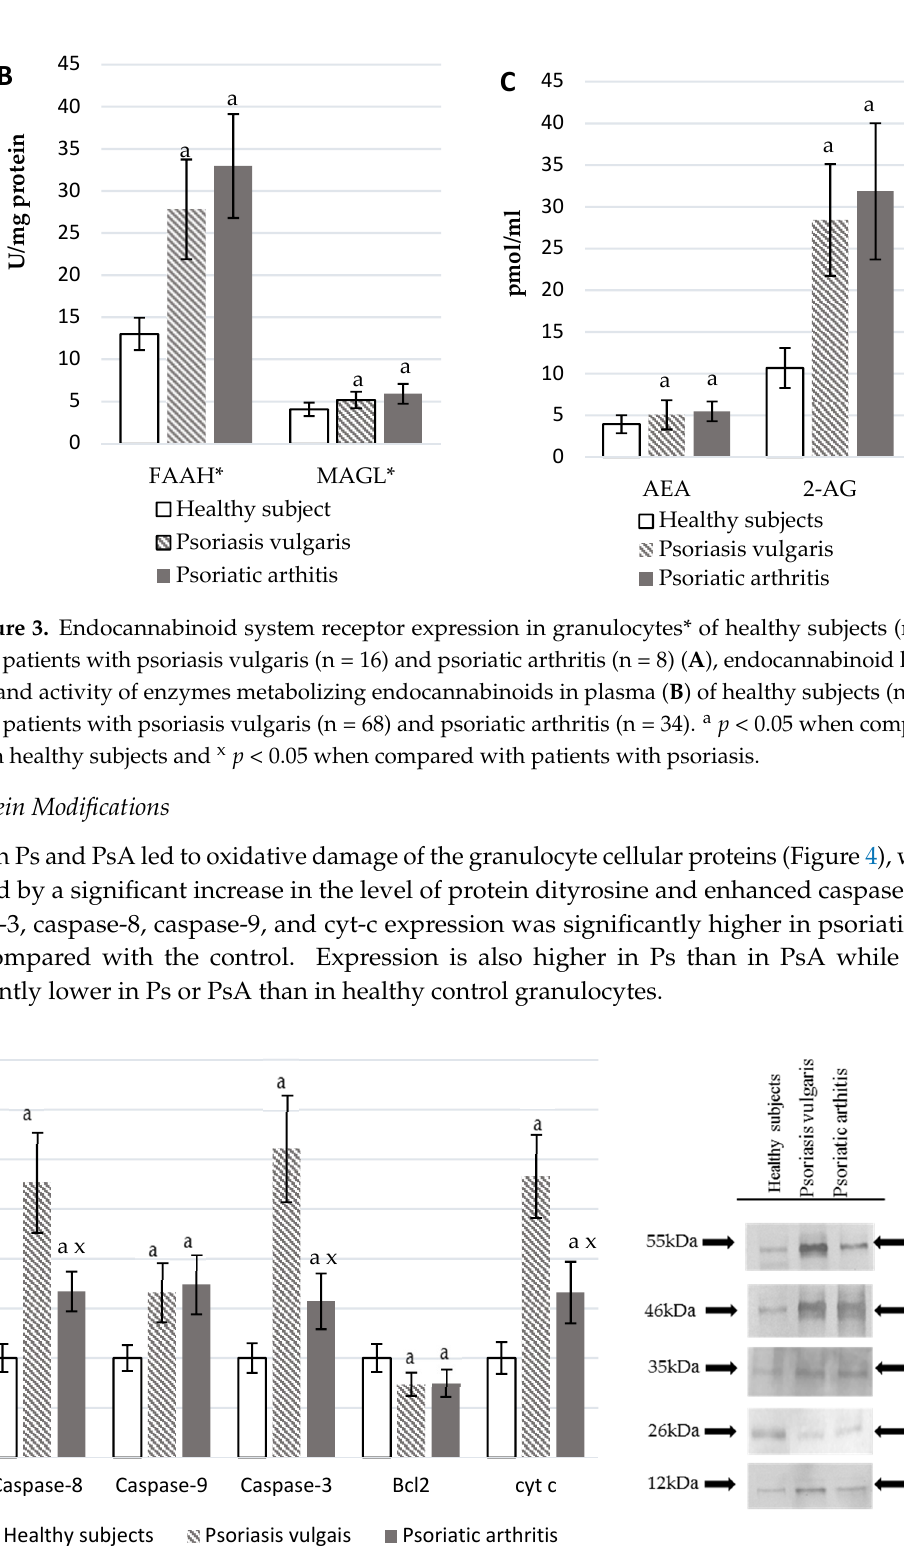
Figure 4. The level of pro-apoptotic proteases (caspase-8, caspase-9, caspase-3) and proteins involved in cell death (Bcl2 and cytochrome c) in granulocytes from healthy subjects (n = 8) and patients with psoriasis vulgaris (n = 16) and psoriatic arthritis (n = 8). a p < 0.05 when compared with healthy subjects. x p < 0.05 when compared with patients with psoriatic vulgaris.